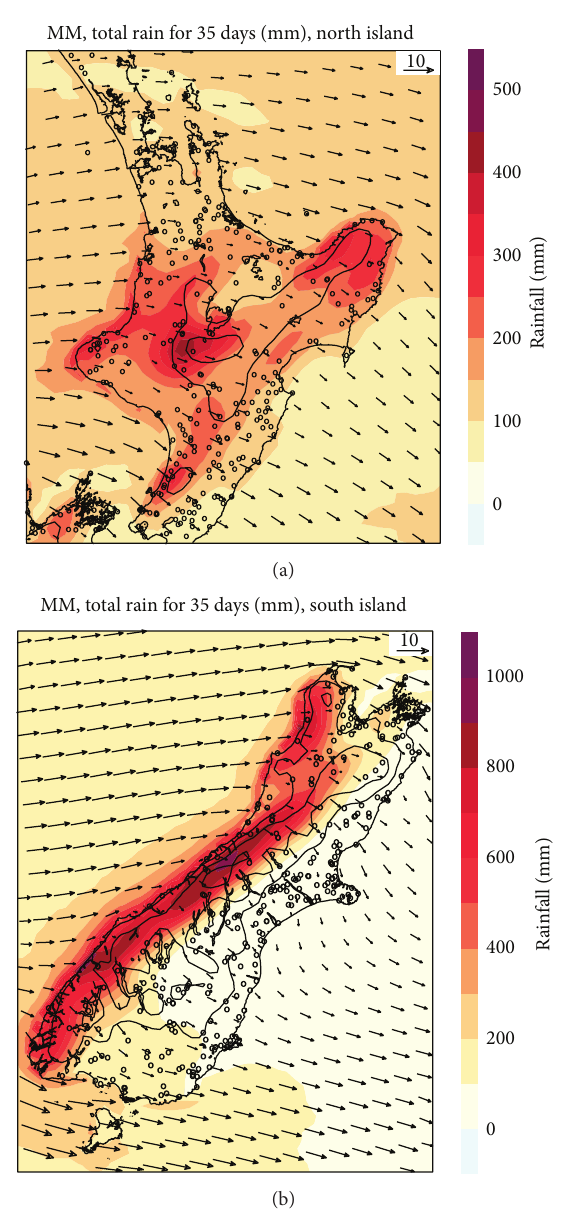
Figure 1: Total rainfall amount (mm) and mean surface wind vectors (ms −1 ) of 35 days from 13 Sept to 18 Oct 2010 for the ensemble mean. The 630 sites with daily rainfall observations used in this study are denoted with open dots. Thin solid lines denote the model terrain contours of 500 m interval. Note the different scales for the two rainfall